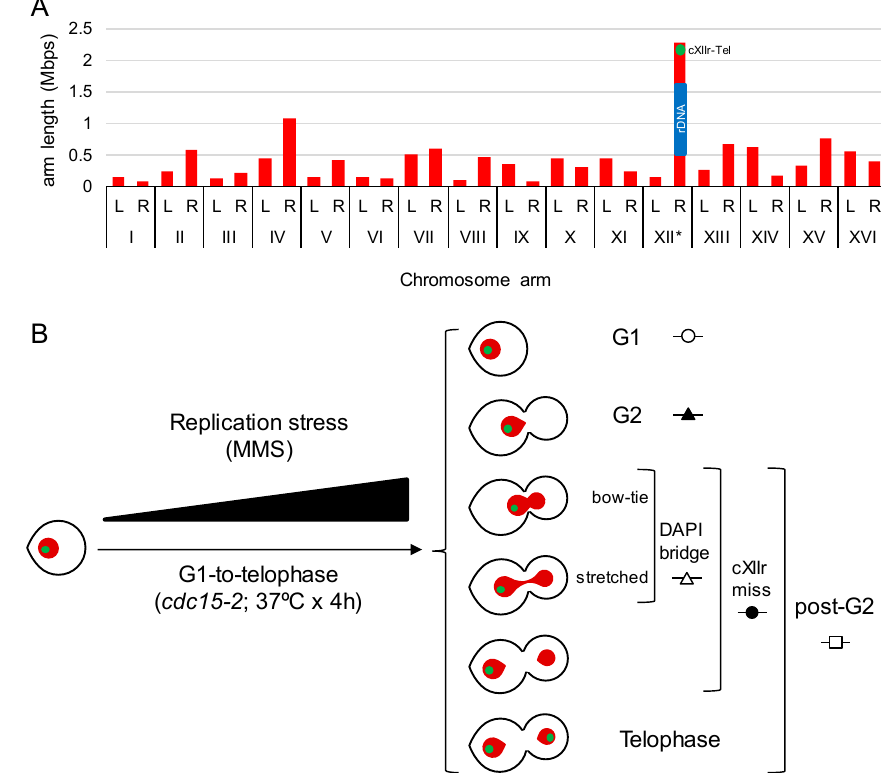
Figure 1. Yeast chromosome arm lengths and cell morphologies obtained after a G1-to-telophase synchronous cell cycle. ( A ) Chart of S288C chromosome arm lengths. Length of chromosome XII right arm (cXIIr) in an estimate considering 150 copies of the 9.1 Kb ribosomal DNA (rDNA) unit. L, left arm; R, right arm; blue rectangle, rDNA array; green dot, position of the engineered tetOs array present in all strains of this study. ( B ) Schematic of the G1-to-telophase experiments, undertaken in this study under increasing doses of replication stress, and the main end-point cell figures considered for analysis. Red, main nuclear mass stained by DAPI, green spot, cXIIr subtelometic region (Tel-cXIIr) as seen by the tetOs /tetR-YFP